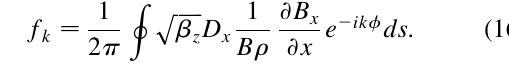
(cid:4) (cid:2) 2 (cid:1) k 2 (cid:5) =(cid:2) derived from the k z z of k